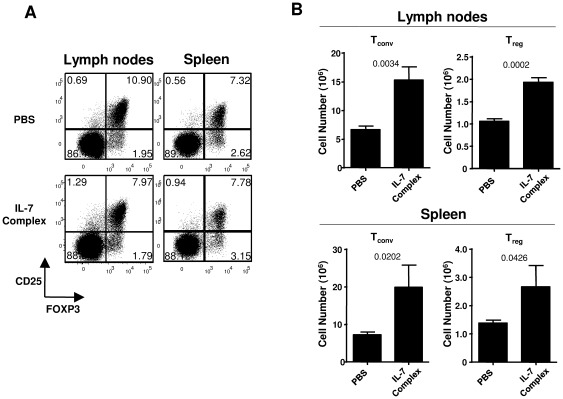
IL-7 complexes treatment induced both conventional and regulatory T cell expansion.C57Bl/6 mice were i.p. injected with PBS or IL-7/anti-IL-7 complexes (1 µg rmIL-7 plus 5 µg M25) three times at 2 day intervals. LN and SP cells were analyzed 7 days after the first injection. (A) Representative dot plots of CD25 vs FOXP3 expression on CD4+TCRβ+ cells recovered from PBS or IL-7 complexes treated mice. (B) Total number of CD4+TCRβFOXP3− conventional T cells (left panels) and CD4+ TCRβ FOXP3+ regulatory T cells (right panels) from lymph nodes and spleen.